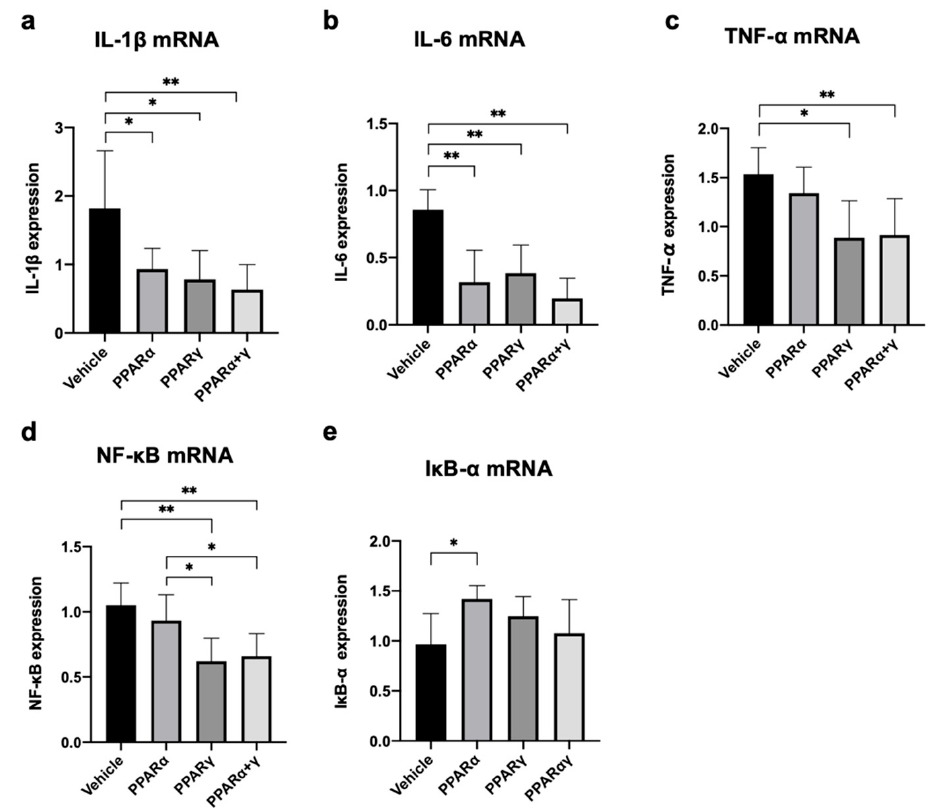
Figure 5. Expression of mRNA for proinflammatory cytokines in the cornea at 6 h after alkali burn. We measured mRNA expression levels of IL-1 β ( a ), IL-6 ( b ), TNF- α ( c ), NF- κ B ( d ), and I κ B- α ( e ). Treatment with all PPAR agonists equally suppressed expression of IL-1 β and IL-6 mRNA ( a and b ). Instillation of PPAR γ and PPAR α + γ agonists also reduced the mRNA expression of TNF- α and NF- κ B in comparison with vehicle instillation ( c ), ( d ). On the other hand, only PPAR α treatment increased the mRNA expression of I κ B- α compared with vehicle treatment ( e ). Data are presented as the mean ± standard error ( n = 8 samples / group). ** p < 0.01, * p < 0.05.